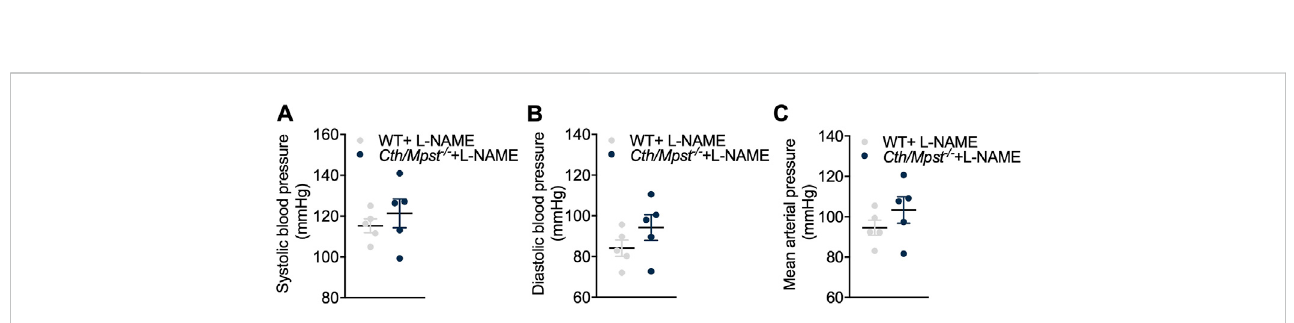
FIGURE 8 No differences in blood pressure between WT and double Cth/Mpst knockout mice after eNOS inhibition. WT and Cth/Mpst − / − mice were exposed to eNOS-inhibitor, L-NAME (0.5 g/L in drinking water) for 10 days and blood pressure was measured. (A) Systolic, (B) diastolic and (C) mean arterial blood pressure of WT and Cth/Mpst − / − mice after L-NAME administration. Data are presented as means ± S.E.M, N = 5 mice per